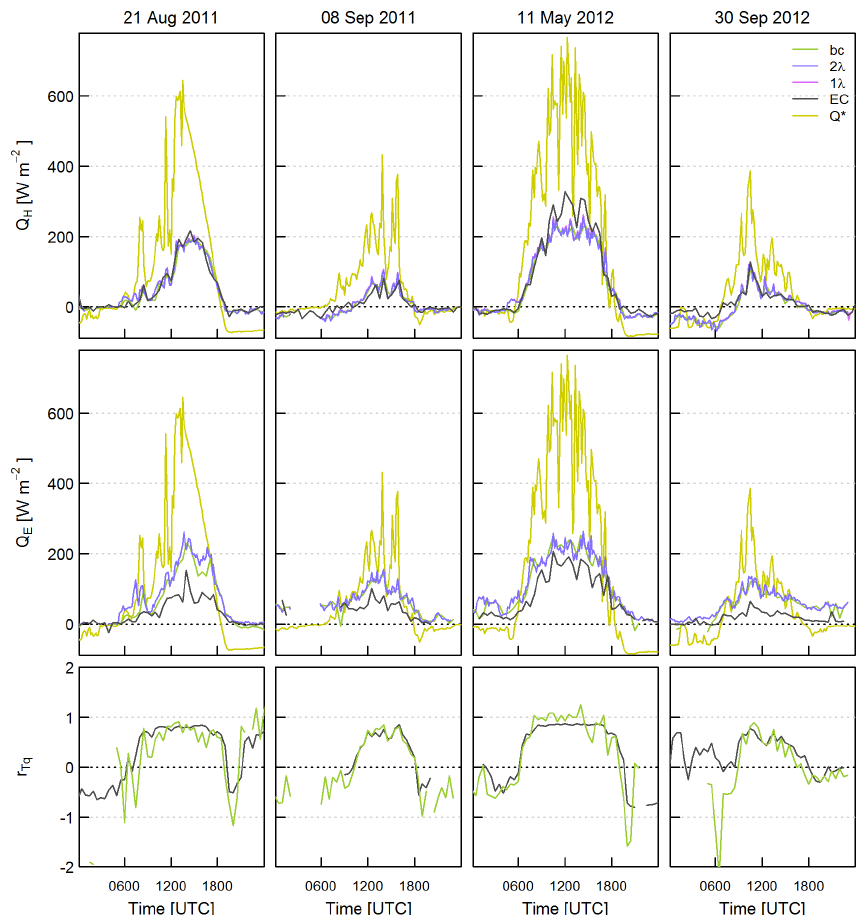
Figure 4. Sensible and latent heat fluxes and net all-wave radiation ( Q ∗ ) and the temperature–humidity correlation coefficient for selected days. Single-wavelength and two-wavelength results are for 10min intervals; EC and bichromatic statistics are at 30min intervals (structure parameters for the same days are shown in Fig. 8 of Part